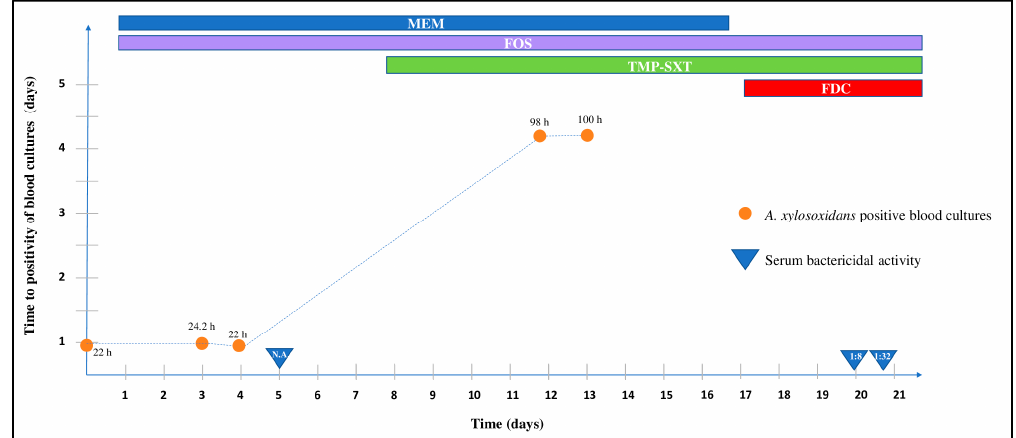
Figure 1. Summary of the therapeutic regimen and bacteriological tests carried out during the infectious diseases ward stay. N.A.: no activity; MEM: meropenem; FOS: Fosfomycin; TMP-SXT: trimethoprim-sulfamethoxazole; FDC: cefiderocol.